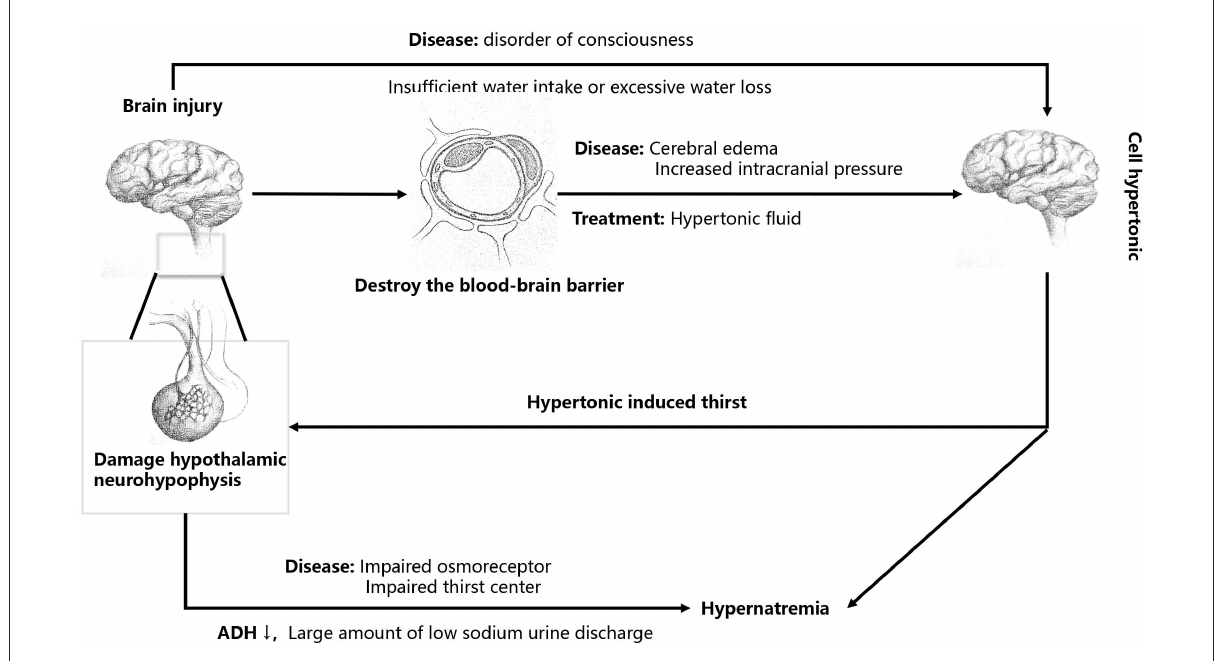
FIGURE1 The mechanisms of brain injury in patients with